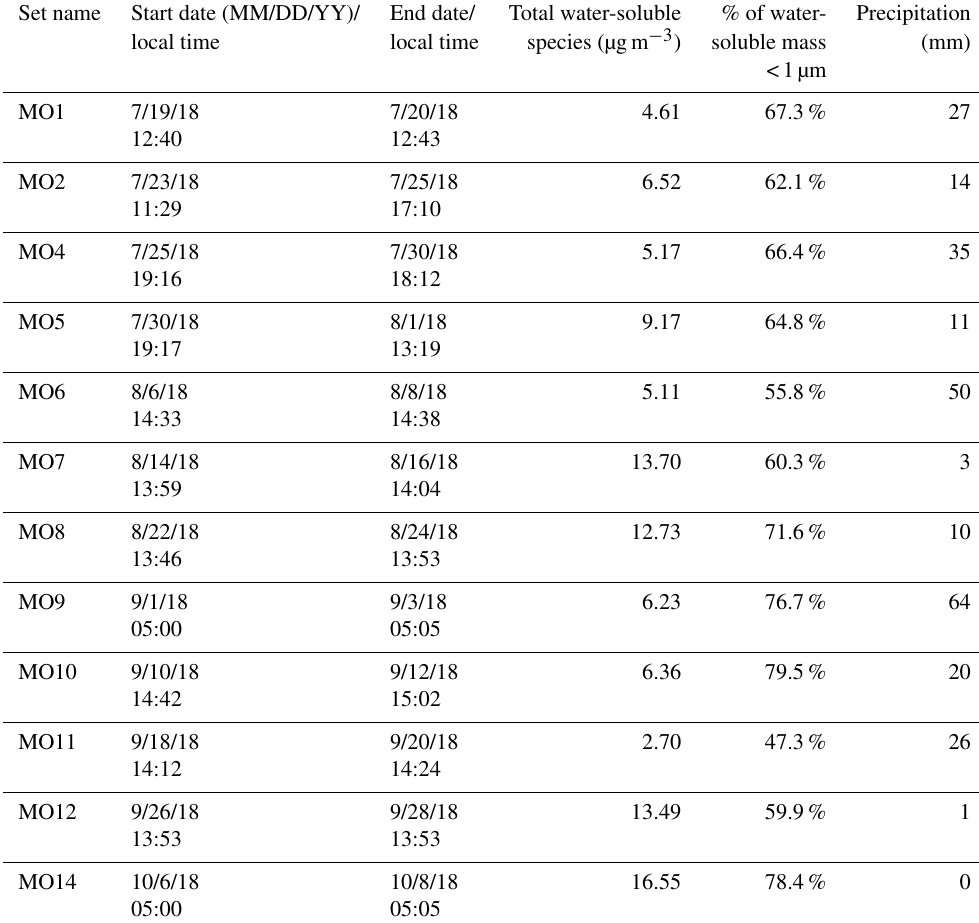
Table 1. Description of the MOUDI sample sets from this study. Accumulated precipitation during the sample sets was found using PERSIANN-CCS for the area bounded by 14.6067–14.6946 ◦ N and 121.0199–121.0968 ◦